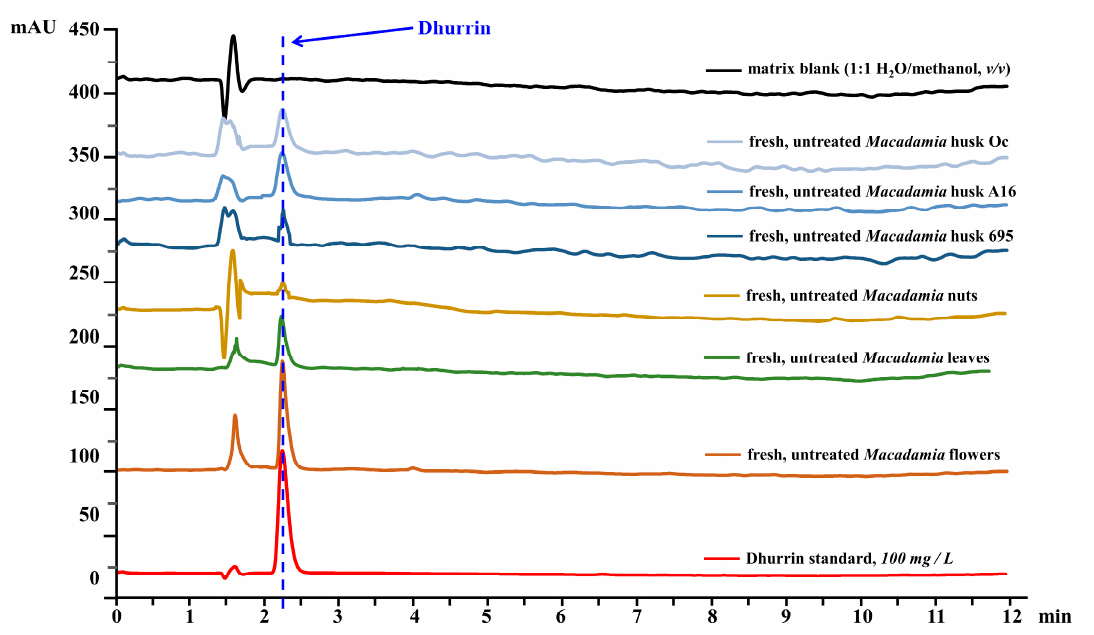
Figure 3. Representative HPLC chromatograms showing the dhurrin spectral peak in 100 mg / L dhurrin standard, matrix blank (1:1 H 2 O / methanol, v / v ), and extracts of fresh, untreated Macadamia flowers, leaves, nuts, husk 695, husk A16, and husk Oc. Dhurrin was monitored at 232 nm absorbance using a diode array detector.